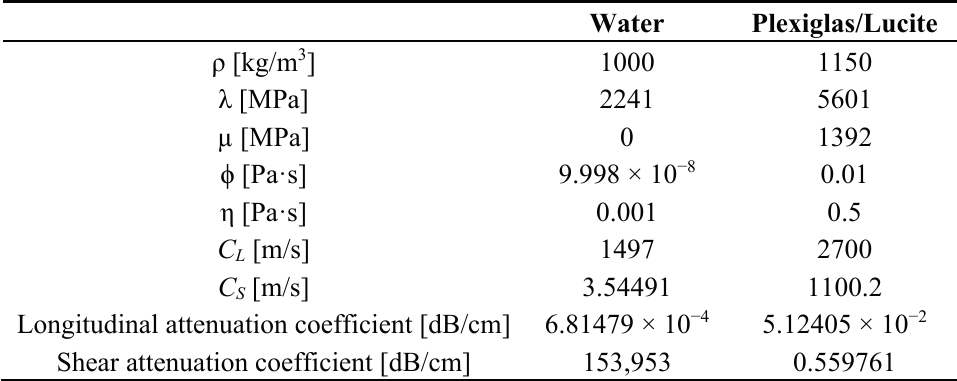
Table 1. Material properties used in